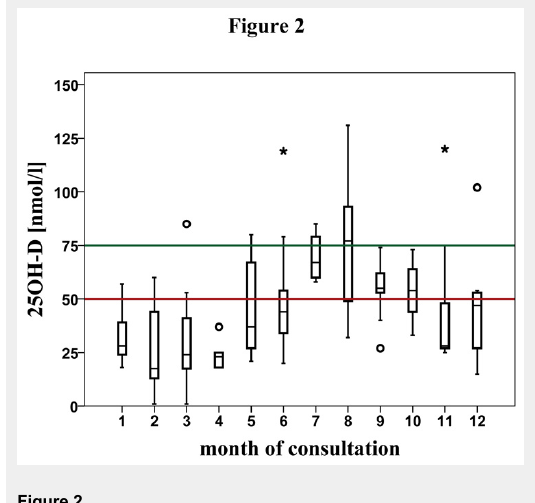
Boxplot of 25-OH-D by month of consultation Circles indicate outliers (one and a half to three box-lengths outside the box), asterisks indicate extreme values (more than three box- lengths outside the box). The top line indicates the cut-off for vitamin D insufficiency (75 nmol/L), the bottom line indicates the cut-off for vitamin D deficiency (50 nmol/L). January corresponds to month 1, December to month